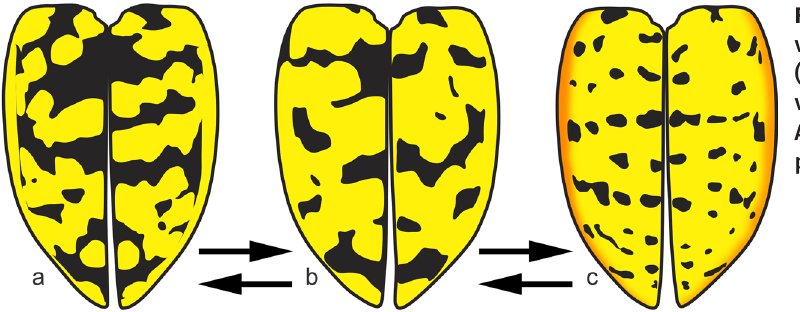
Diagnosis. Erotylina leoparda differs from the other congeneric species by the combination of the following characters: (i) “ leoparda ” morph (e.g. Figures 1a–c; 3a–b, color patterns diagram), elytral color pattern black with yellow elytral spots confluent but not completely fused; elytral epipleuron yellow. (ii) “ nicaraguae ” morph (e.g. Figures 1d–e; 3c, color diagram), elytral color pattern with circular yellow spots completely fused and transverse elytral black marks, arranged more or less symmetrically (e.g. Figure 1e) or, similar to “ leoparda ” members, with a black background and yellow elytral spots somewhat confluent, but not completely fused (e.g. Figure 8c–d); lateral edge of elytra and epipleuron orange (Figure 8). Additional characters: tibiae thin, smooth, lacking longitudinal carinae (Figure Figure 3. Examples of color pattern variations in Erotylina leoparda (Lacordaire, 1842). a–b. “ leoparda ” variations. c. “ nicaraguae ” variation. Arrows indicate plasticity among